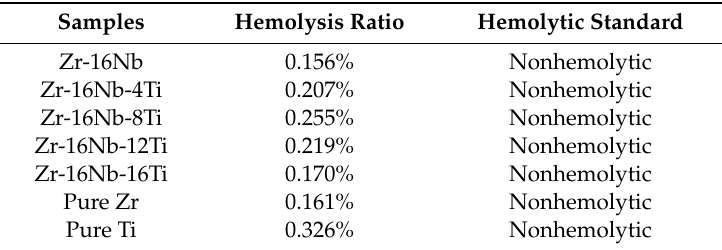
Table 4. Hemolysis rate of testing